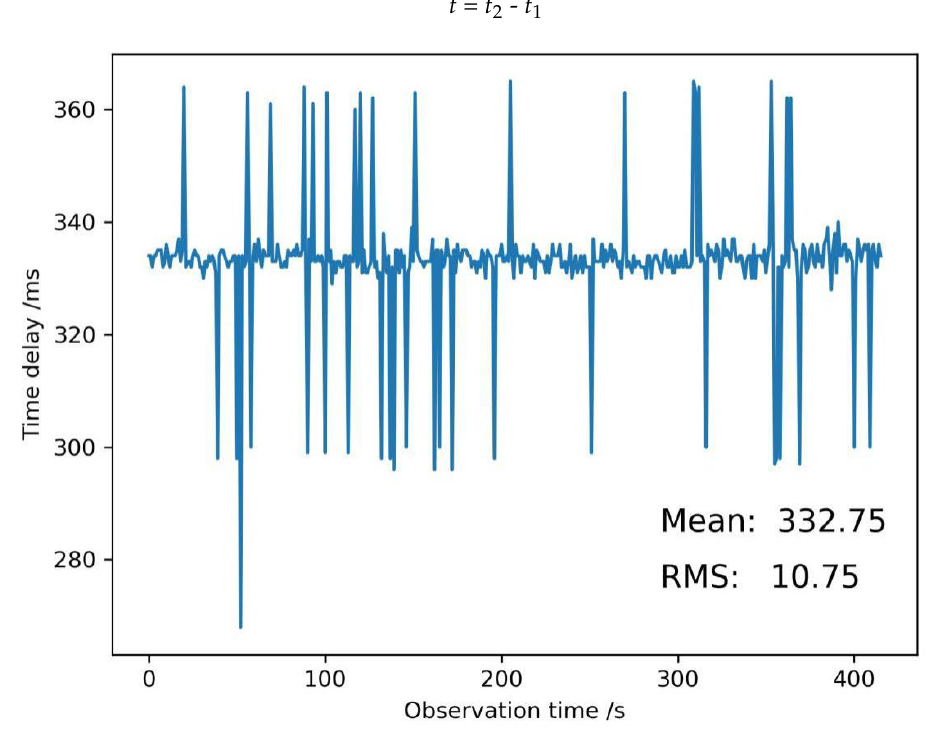
Figure 6. Encryption time delay of GNSS RTCM data in a GNSS sensor.